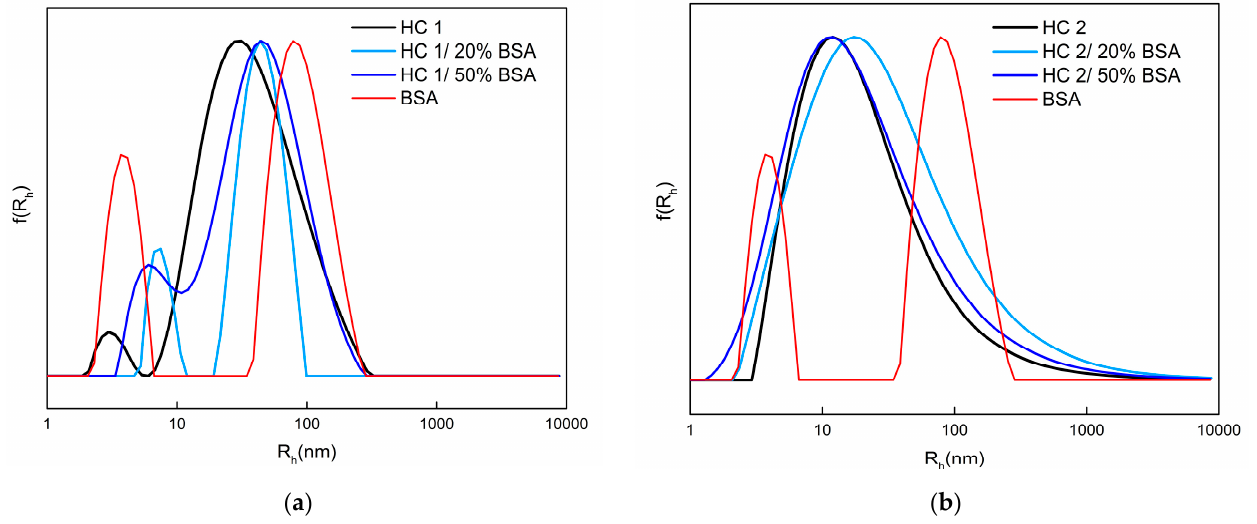
Figure 10. Size distributions from DLS for HC 1 ( a ) and HC 2 ( b ) co-assembly with BSA. Table 5. DLS and ELS results for HC–BSA co-assemblies.